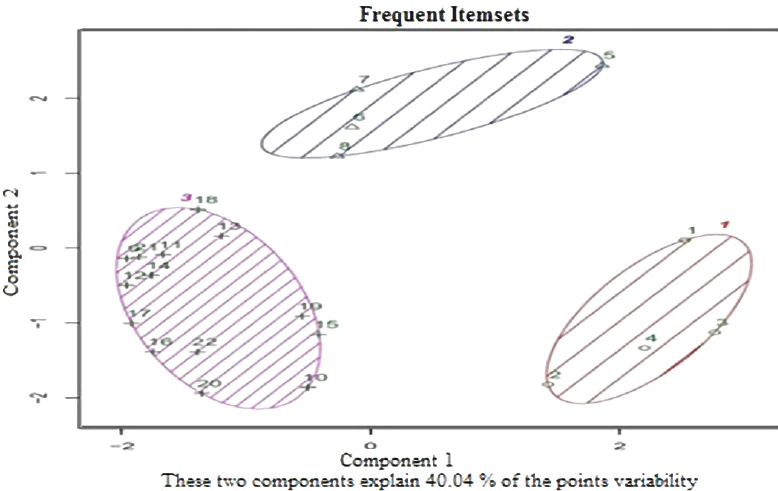
Fig. 6. K -Medoids clustering using frequent itemsets with K ¼ 3 .